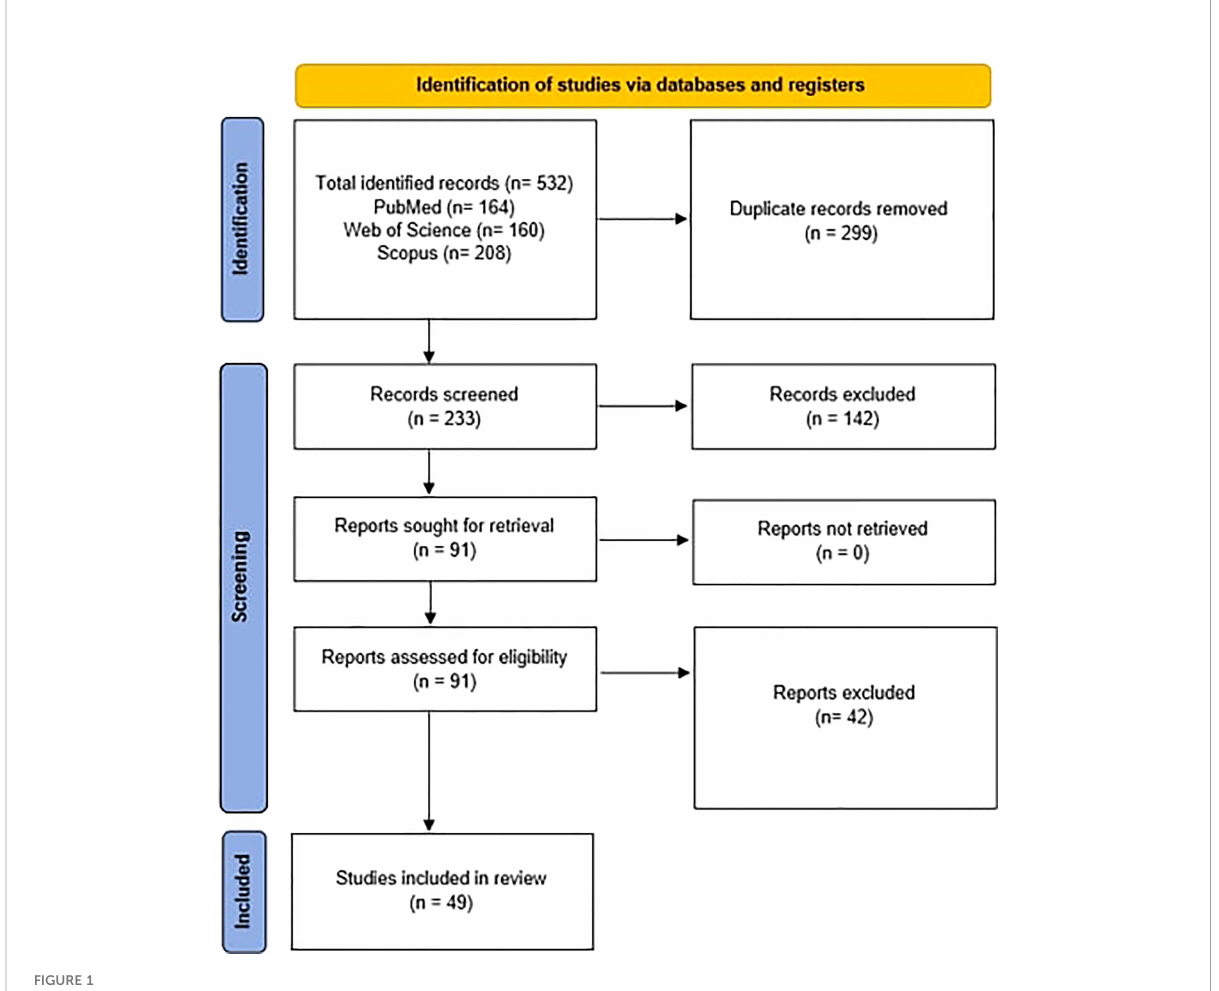
FIGURE 1 PRISMA fl ow